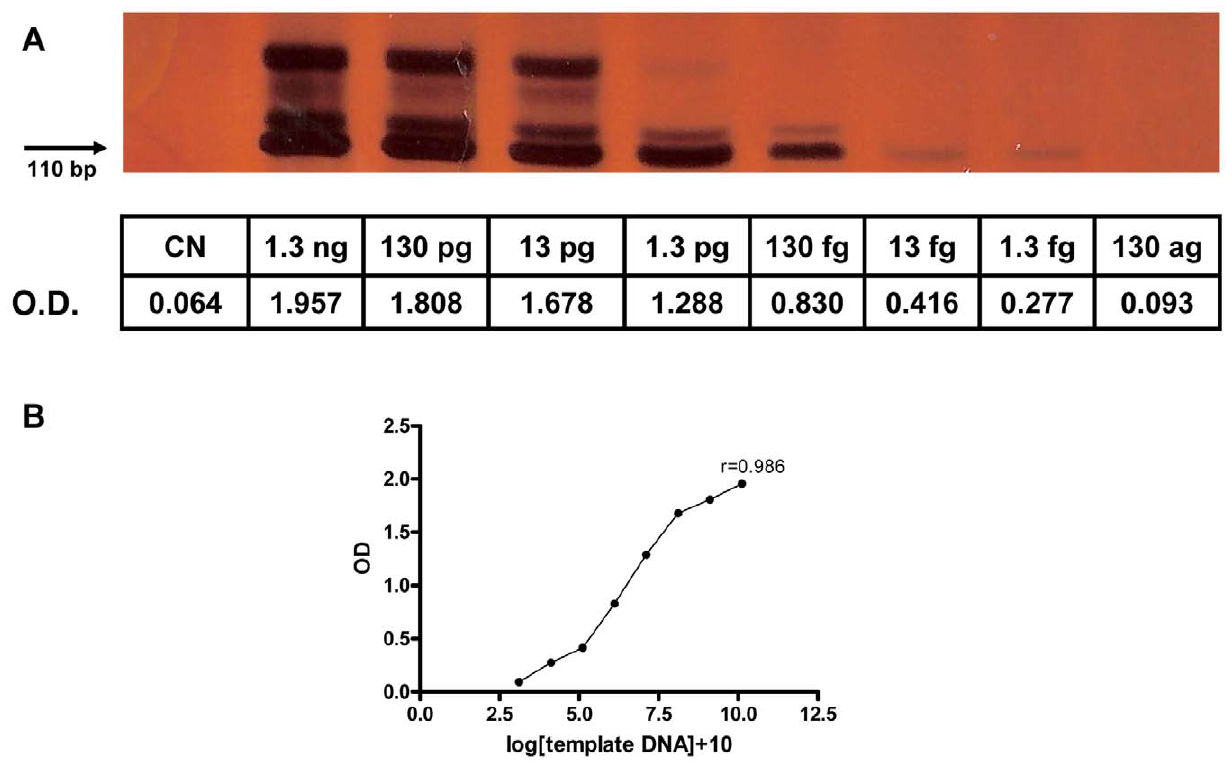
Figure 1. Analytical sensitivity of PCR-ELISA system. A. Analytical sensitivity of PCR followed by 6% polyacrylamide gel electrophoresis with silver staining and ELISA (optical density, OD) for 10-fold serial dilutions of genomic DNA extracted from a saline solution containing , 2,000 S. mansoni eggs. The detection limit was 1.3 fg of genomic DNA. A ladder-type banding pattern was exhibited, as expected, due the amplification of the Schistosoma tandem-repeated unit, with the main DNA band of 110 bp present in all samples. B. The Pearson’s correlation coefficient between PCR-ELISA OD and log[template DNA] + 10 was 0.986 ( P , 0.0001).